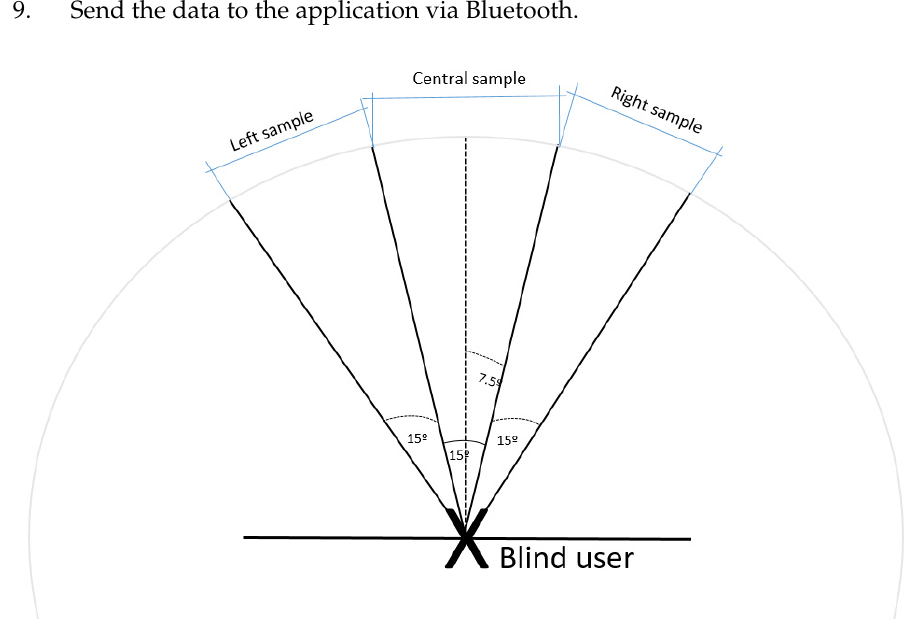
Figure 4. Angle detection of the servo-sonar system.